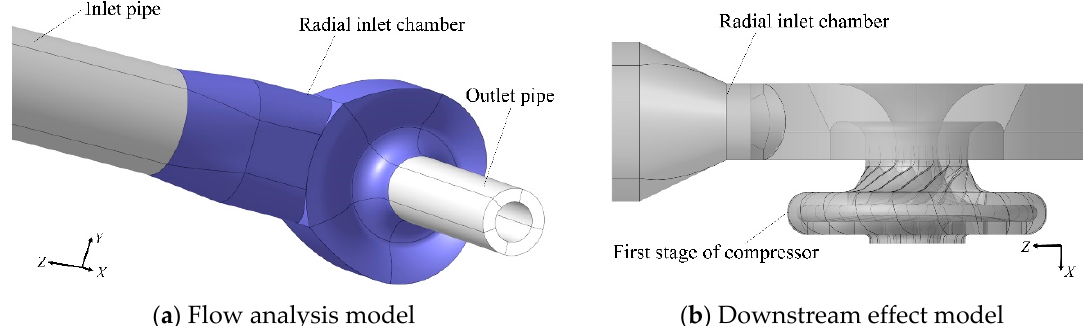
Figure 2. Computational models for flow analysis and the downstream effects of the radial inlet chamber.